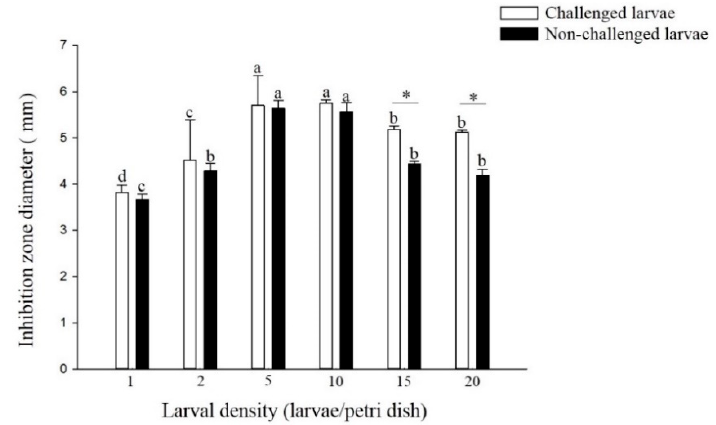
Figure 4. Antibacterial activity of larval P. xylostella reared at different larval densities. Bars of non-challenged (or challenged) larvae with the same letter are not significantly different at the 0.05 level by Tukey’s HSD multiple comparison. The asterisk indicates a significant difference at the 0.05 level by Student’s t -test between the non-challenged and challenged groups.